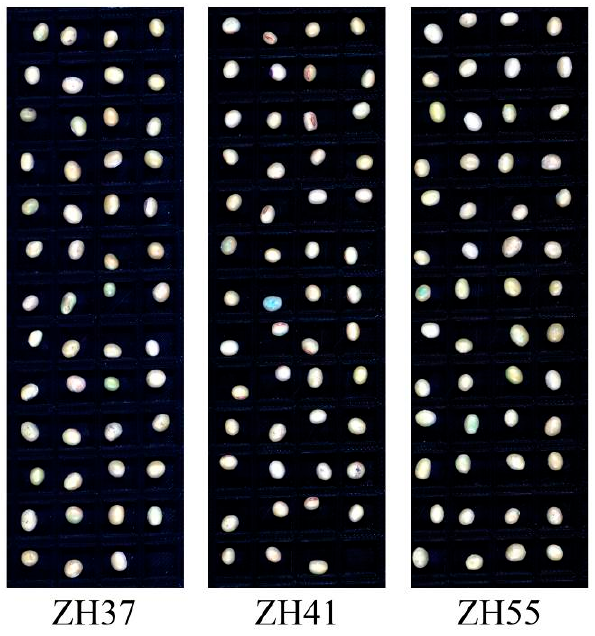
Figure 1. RGB (Red Green Blue) images of three varieties of soybeans.